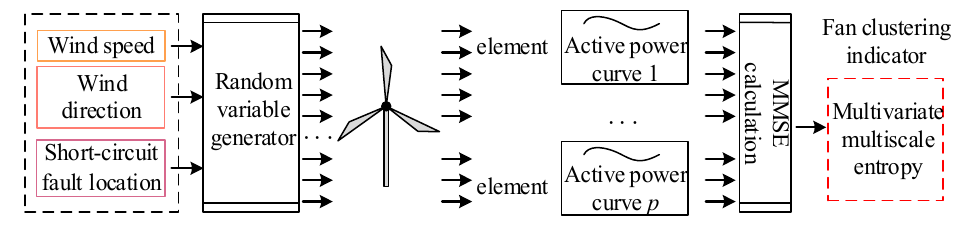
Figure 4. Extraction process of WT cluster indicator.